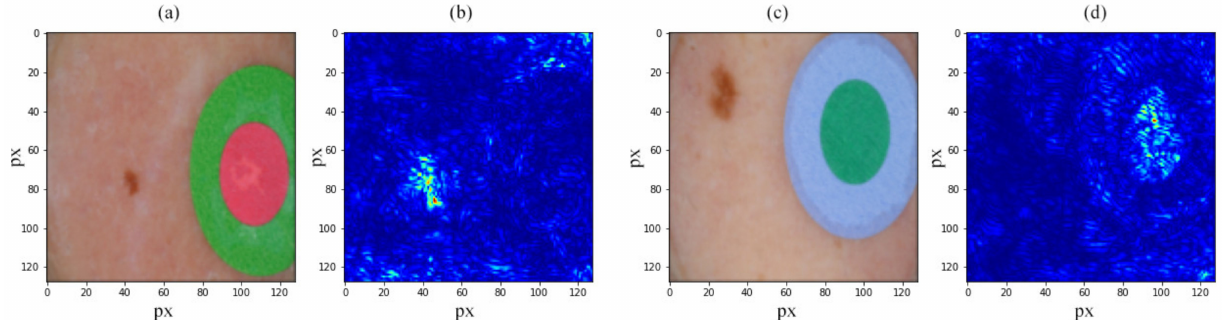
Figure 1. Nevus and marker RGB images from ISIC archive ( a , c ) and saliency maps acquired via pre-trained ResNet50 fine-tuned on ISIC dataset showing good inference relying on the lesion ( b ) and inference relying on a marker, which shows model overfitting ( d